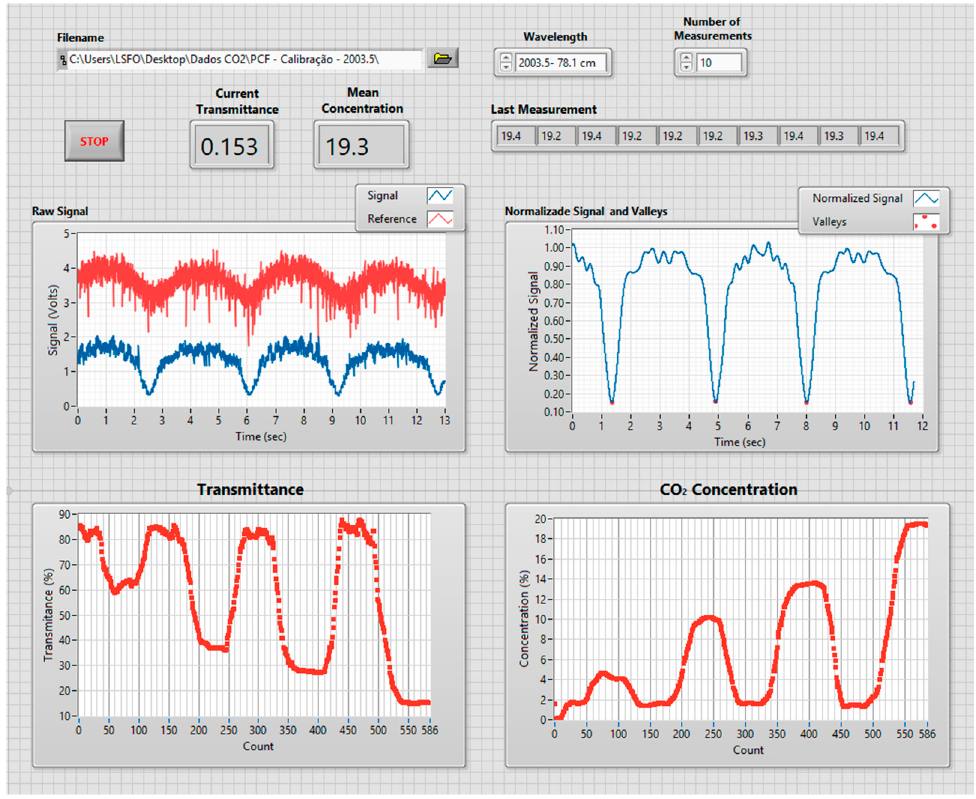
Figure 5. Computer interface of the acquisition and processing unit of the sensor.